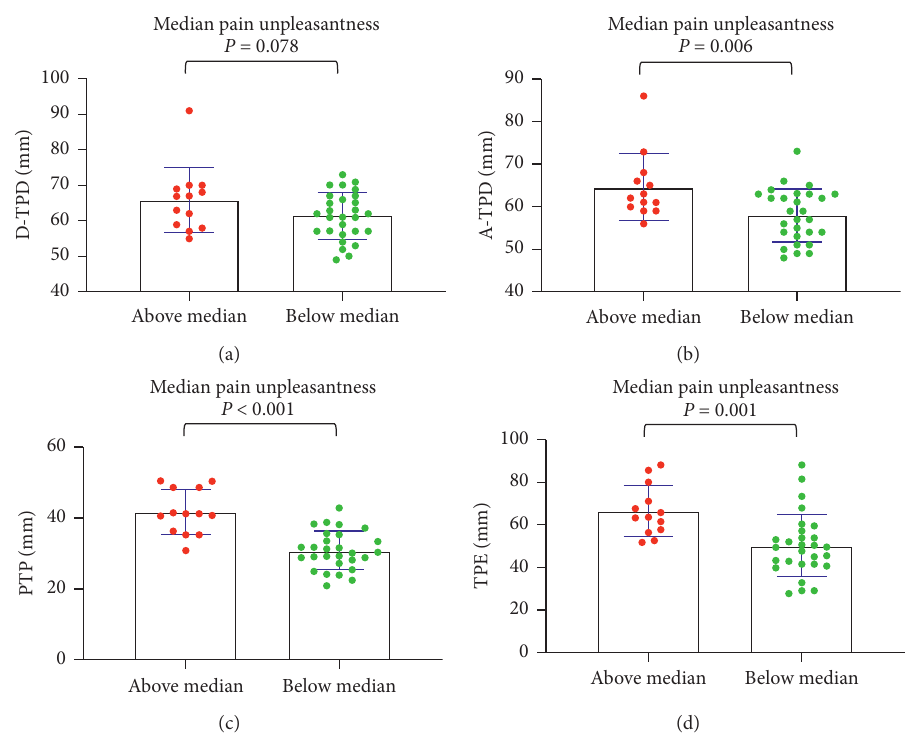
Figure 4: Tactile acuity for median pain unpleasantness in the abovemedian group versus the belowmedian group. (a) D-TPD, (b) A-TPD, (c) PTP, and (d) TPE. The median of pain unpleasantness was 7. D-TPD � two-point discrimination test performed in a descending manner; A-TPD � two-point discrimination test performed in an ascending manner; PTP � point-to-point test; TPE � two-point